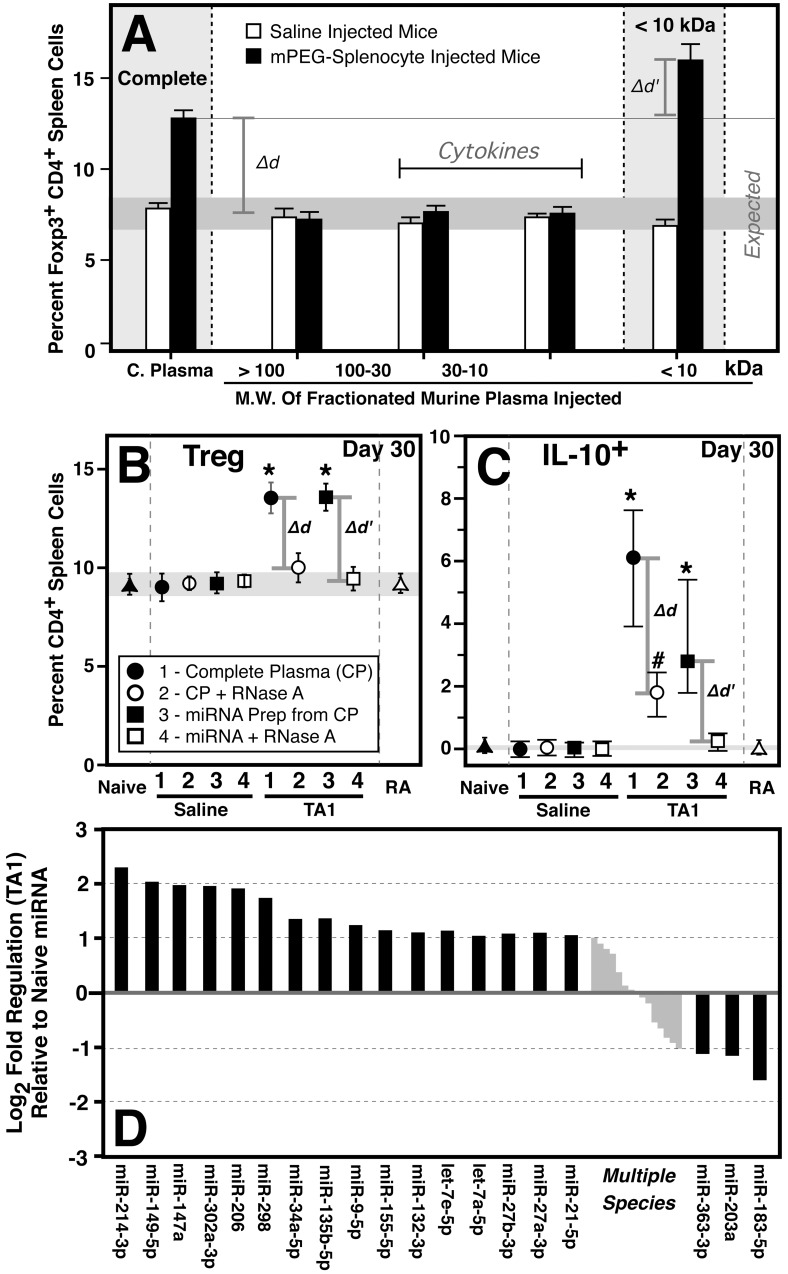
Characterization of miRNA as the functional immunomodulatory agent.
Panel A: Size fractionation of plasma obtained from saline (white) and tolerized (black) mice was done to isolate the tolerogenic fraction(s). As shown, for fractions >10 kDa, in vivo immunodulatory activity was lost (Δd) relative to the complete plasma. In contrast, the <10kDa fraction demonstrated significantly elevated Treg levels (Δd'; p<0.01) relative to complete plasma. Normal Treg levels for naïve mice are denoted by the shaded grey bar. As shown, saline treatment had no immunomodulatory effect. Splenic Treg cells were assessed 5 days post treatment (N≥5 per group). Panels B-C: Comparative in vivo effects of plasma or miRNA prepared from saline and tolerized mice on Foxp3+CD4+ (B) and IL-10+CD4+ (C) lymphocytes at 30 days post treatment. Neither complete plasma nor miRNA prepared from saline treated animals exhibited immunomodulatory activity. In contrast, conditioned plasma and miRNA (TA1) prepared from it, exhibited significant (p<0.001) upregulation of both Treg and IL-10+ cells which was lost if the plasma or TA1 (Panels B-C; Δd and Δd’, respectively) was treated with RNase A (RA) prior to administration. Direct in vivo administration of RA to naive mice had no effect. Values shown are the mean and range of ≥5 animals per group. Panel D: Partial characterization of the tolerogenic TA1-miRNA pattern. miRNA shown represent species with significant variance from the non-tolerogenic (naïve) miRNA preparation (0 value; grey line). The tolerogenic pattern consists of miRNA that are both increased and decreased in relative abundance. Note that multiple other miRNA species are relatively unchanged from naive miRNA but may also be of bioregulatory importance in TA1 activity. Data shown represent a minimum of 3 biological replicates analyzed independently by qPCR.